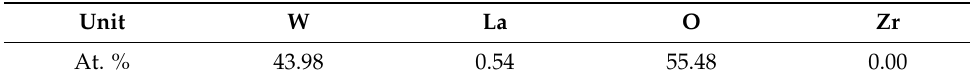
Figure 8. XPS survey of unheated 0.1% ZrH 2. Table 2. Relative content of unheated 0.1% ZrH 2 surface.